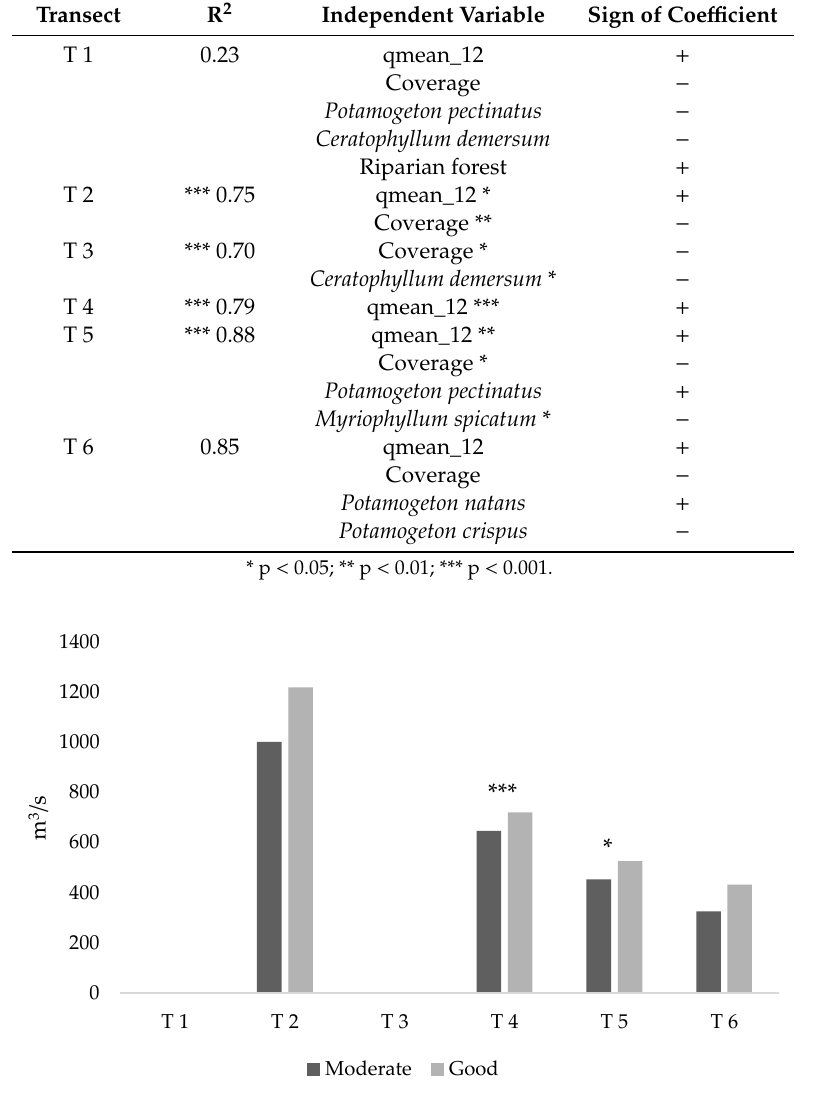
Figure 4. Mean discharges computed with a 12-month period necessary to achieve a moderate and good ecological status in the transects (T) in the absence of aquatic vegetation (significance levels: * p < 0.05; *** p < 0.001).